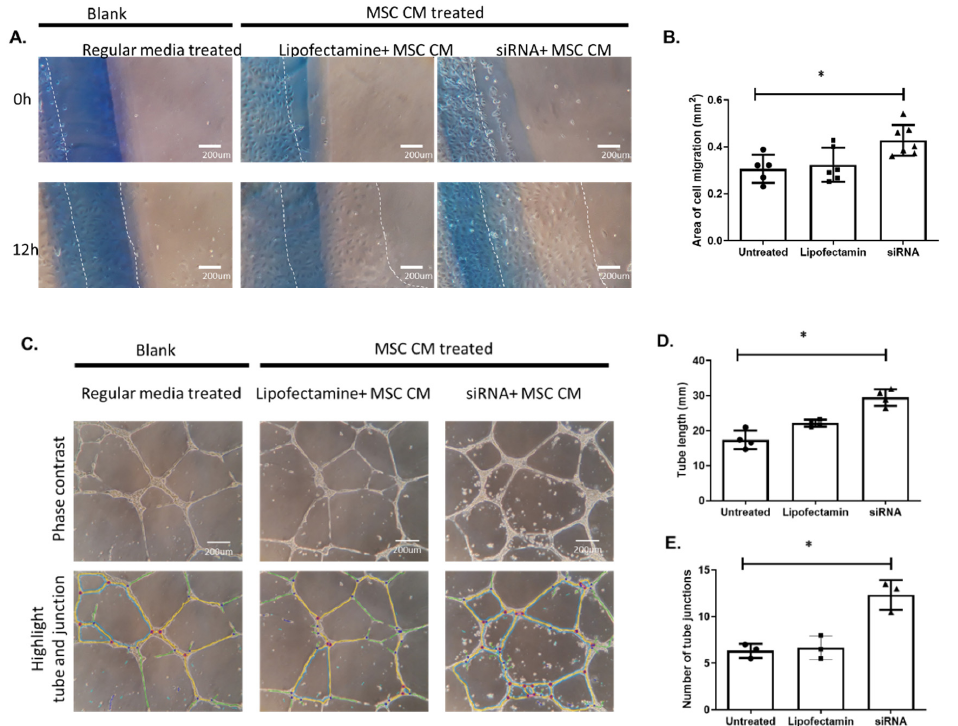
Figure 6. Silencing p75 NTR expression on MSCs improves angiogenic response in HREs. ( A , B ) Representative images and statistical analysis of HREs migration shows significant increase in HREs migration (distance marked from original plating line marked with blue pen) after 12 h treatment with CM of p75 NTR -silenced MSCs (*, significance using one-way ANOVA test, n = 5–7. ( C – E ) Representative phase contrast images ( C ) and statistical analysis for tube length ( D ) and number of tube junction ( E ) formed in vitro by HREs after 24 h treatment with conditioned medium of p75 NTR -silenced MSCs. Results showed significant increase in tube length and number of tube junctions (*, significance using one-way ANOVA test, n = 3). Int. J. Mol. Sci. 2021 , 22 , x FOR PEER REVIEW